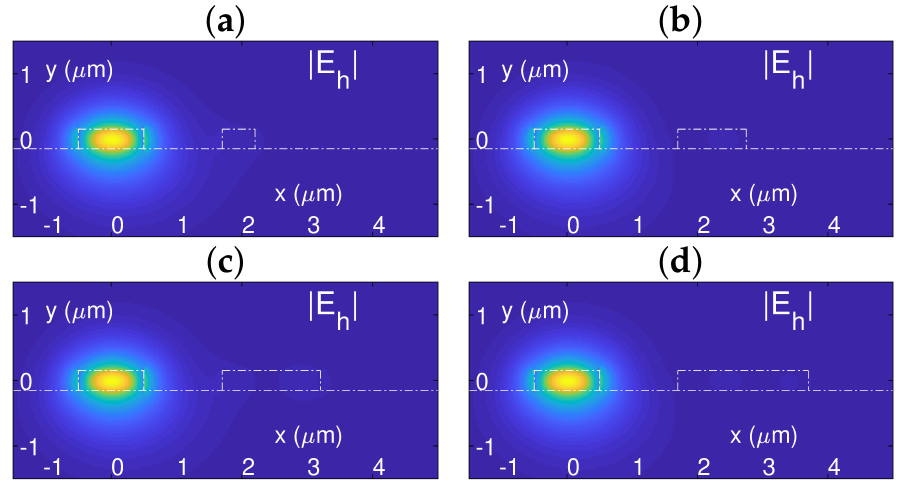
Figure 6. Amplitudes of the horizontal main electric field components of the TE modes propagating in the asymmetric concentric microring structure of Figure 1 with R = 50 µ m. The plots correspond to the respective modal sheets of Figure 5, each of them lying on the plane defined by the effective index of the isolated main waveguide (principal mode). Plots ( a – d ) are for the same value of s = 1.7 µ m and respective values of w e of 0.5, 1.05, 1.5 and 2.0 µ m. The waveguide boundaries are outlined with a dashed white